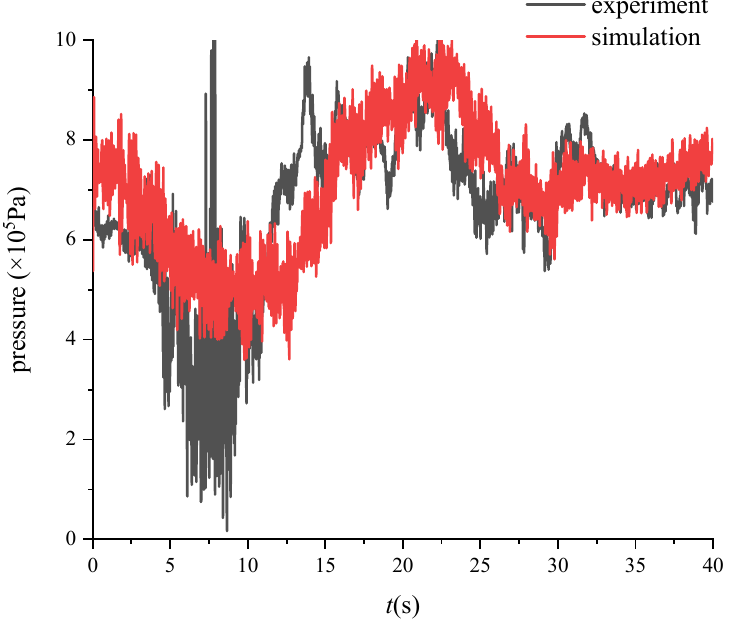
Figure 10. Comparison of the draft tube inlet pressure results.